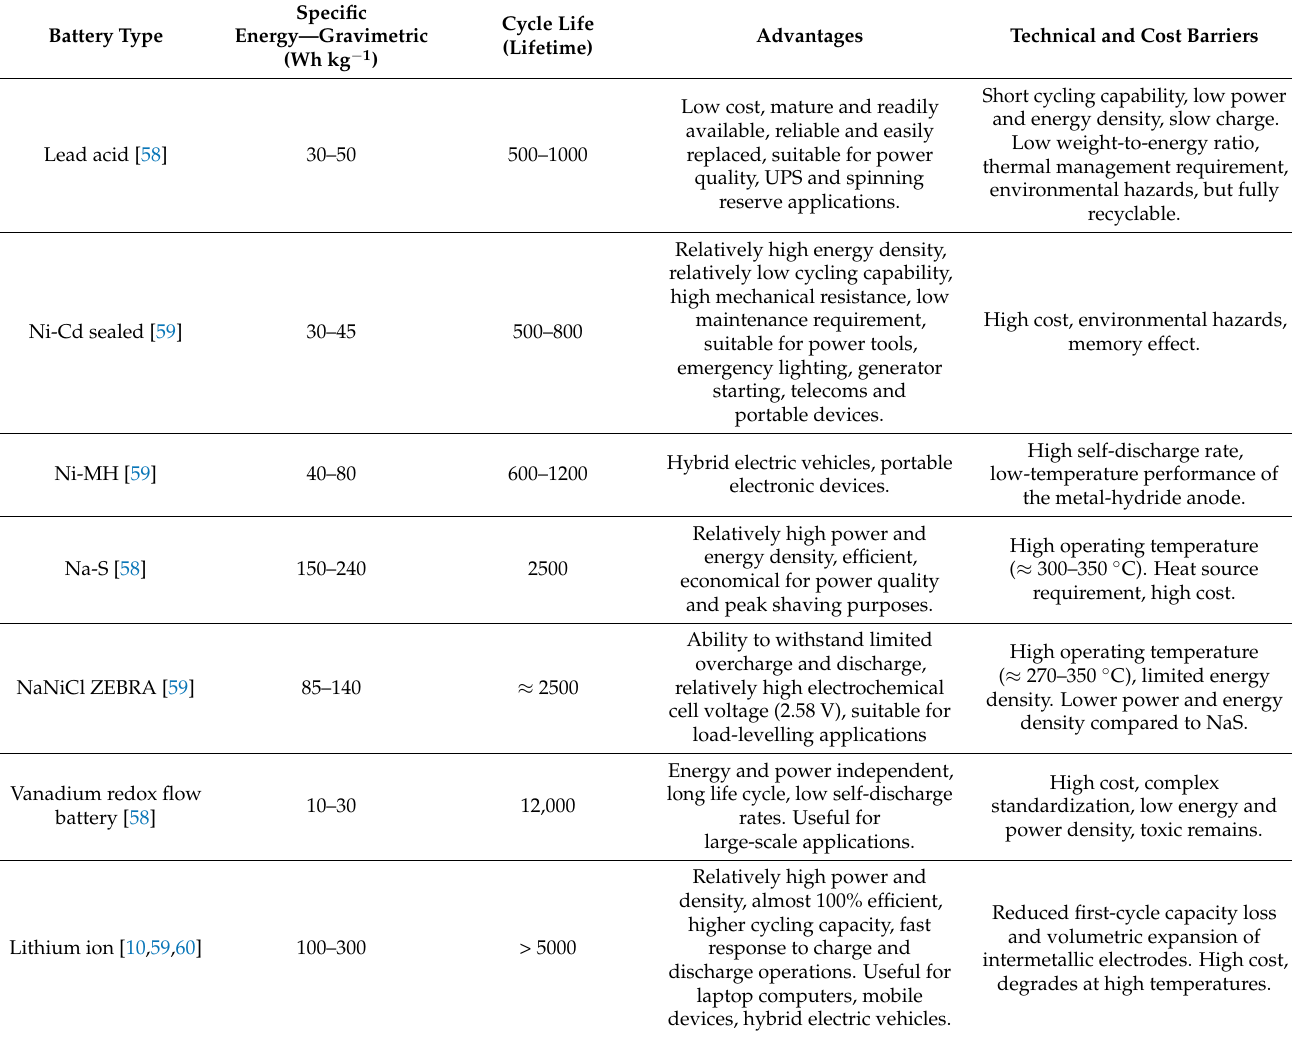
Table 1. Main battery technologies, along with typical electrochemical performance, application and constrains. Adapted with permission from [10]. Copyright Elsevier B.V.,